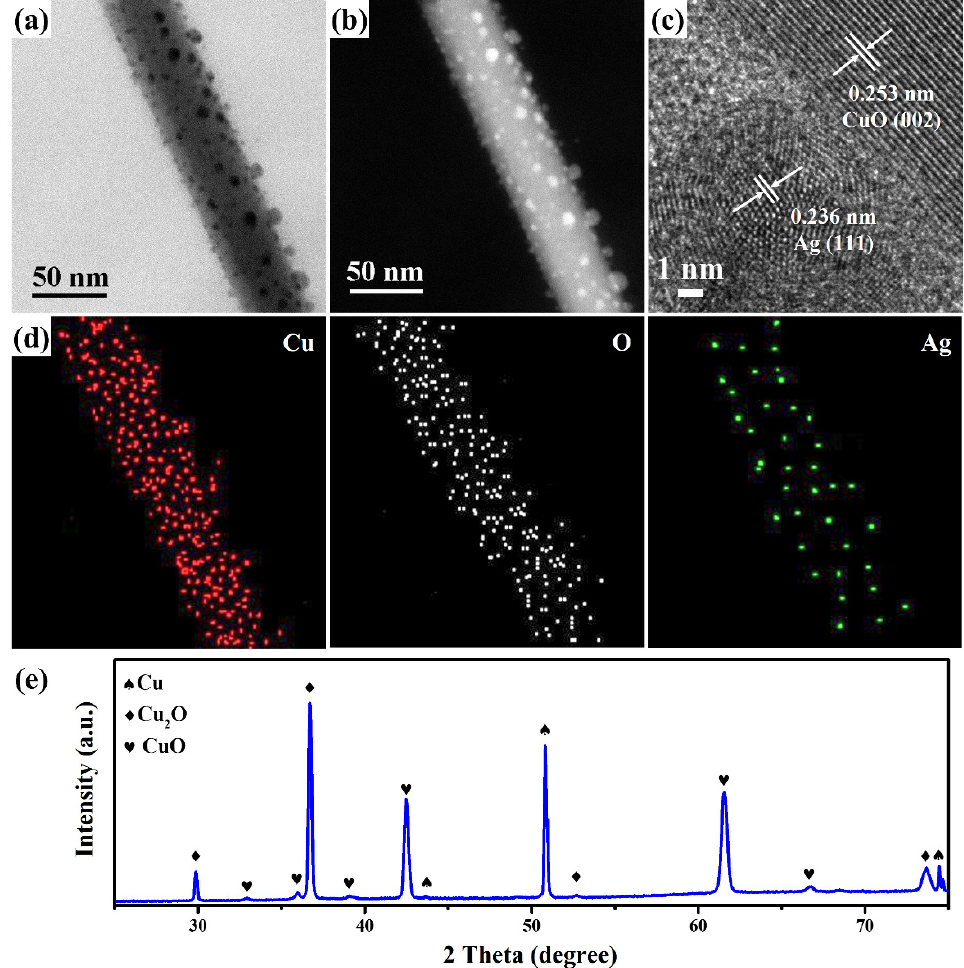
Figure 3. The ( a ) FETEM, ( b ) HAADF, ( c ) HRTEM, and ( d ) EDS mapping images of a CuO@Ag nanowire grown by an ion ‐ sputtering method for 30 s. ( e ) XRD diffraction pattern of